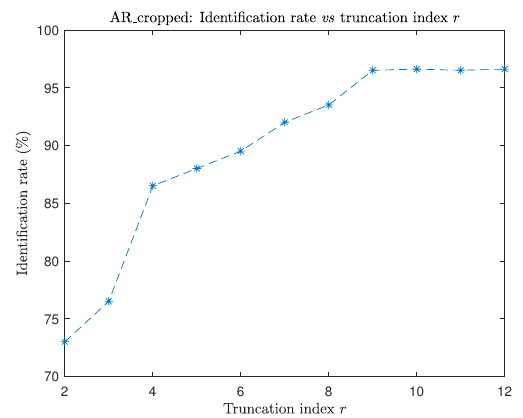
Figure 8. Test image, closest image, mean image and eigenface. We applied our approach (TTPCA) to the 10,000 × 2000 × 3 training tensor X and plotted the recognition rate as a function of the truncation index in Figure 9.